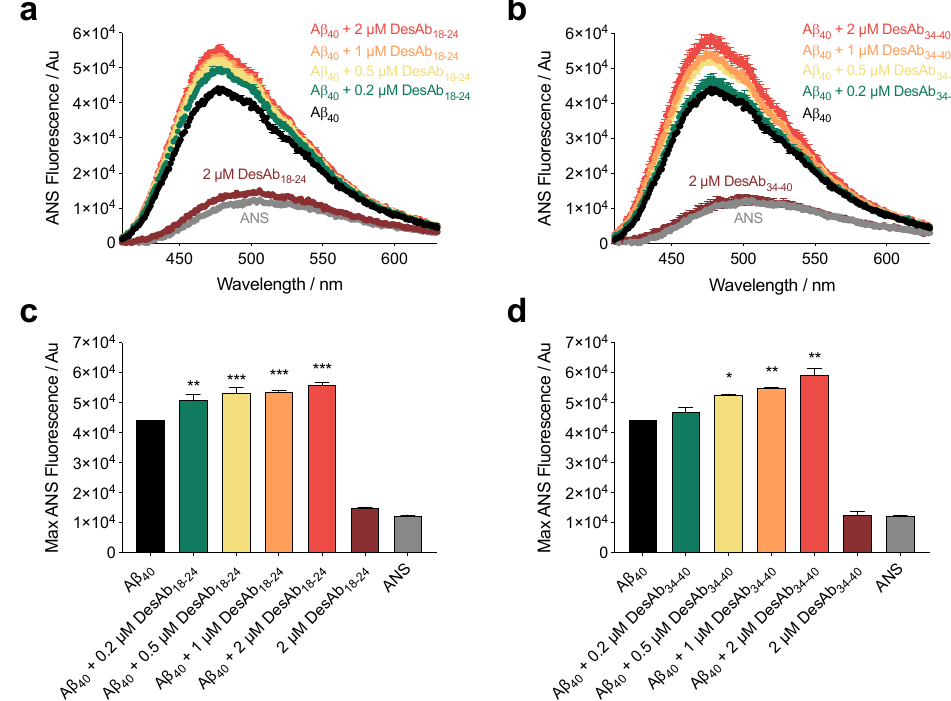
Figure 2. DesAb 18-24 and DesAb 34-40 increase the hydrophobic area of stabilized A β 40 oligomers. ANS binding measurements for oligomers of A β 40 incubated at a concentration of 10 µ M in the absence (black) or presence of 0.2 µ M (green), 0.5 µ M (yellow), 1 µ M (orange) and 2 µ M (red) DesAb 18-24 ( a ) and DesAb 34-40 ( b ). The intensity of maximum ANS fluorescence for DesAb 18-24 ( c ) and DesAb 34-40 ( d ), determined from the spectra indicated in ( a ) and ( b ), respectively. Note that the highest concentration of DesAbs tested (2 µ M, dark red) did not significantly change the fluorescence of free ANS (grey) in the absence of oligomers. Error bars denote SEM of duplicate spectra. Samples containing oligomers were analyzed by one-way ANOVA followed by a Bonferroni’s multiple comparison test relative to oligomers in bu ff er. The symbols *, **, and *** indicate p < 0.05, 0.01 and 0.001,